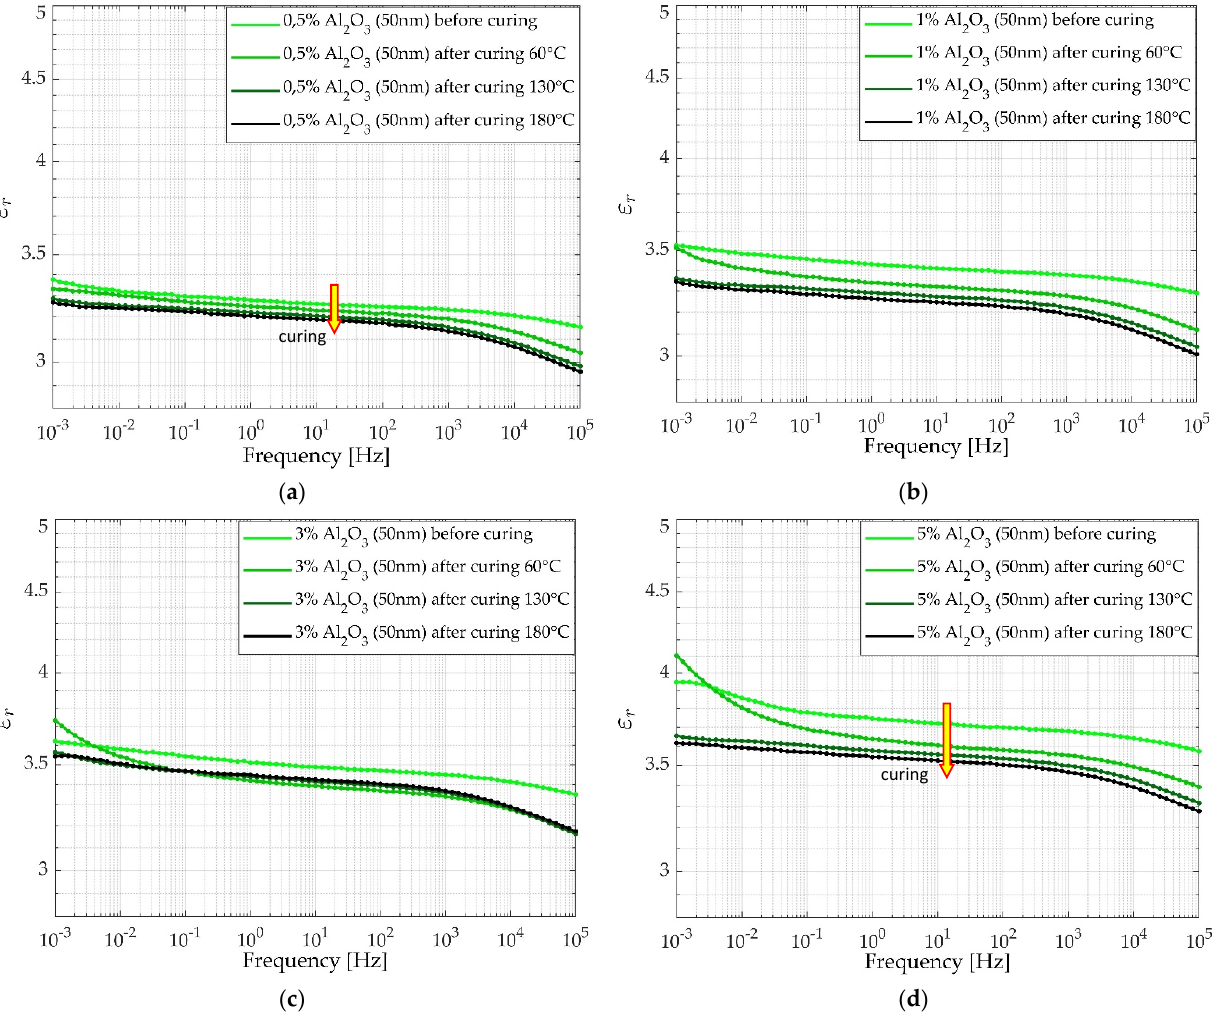
Figure 6. Broadband dielectric constant ε r ( f ) characteristics for samples with Al 2 O 3 , with particles of 50 nm and different wt% loadings: ( a ) 0.5%, ( b ) 1%, ( c ) 3%, ( d )